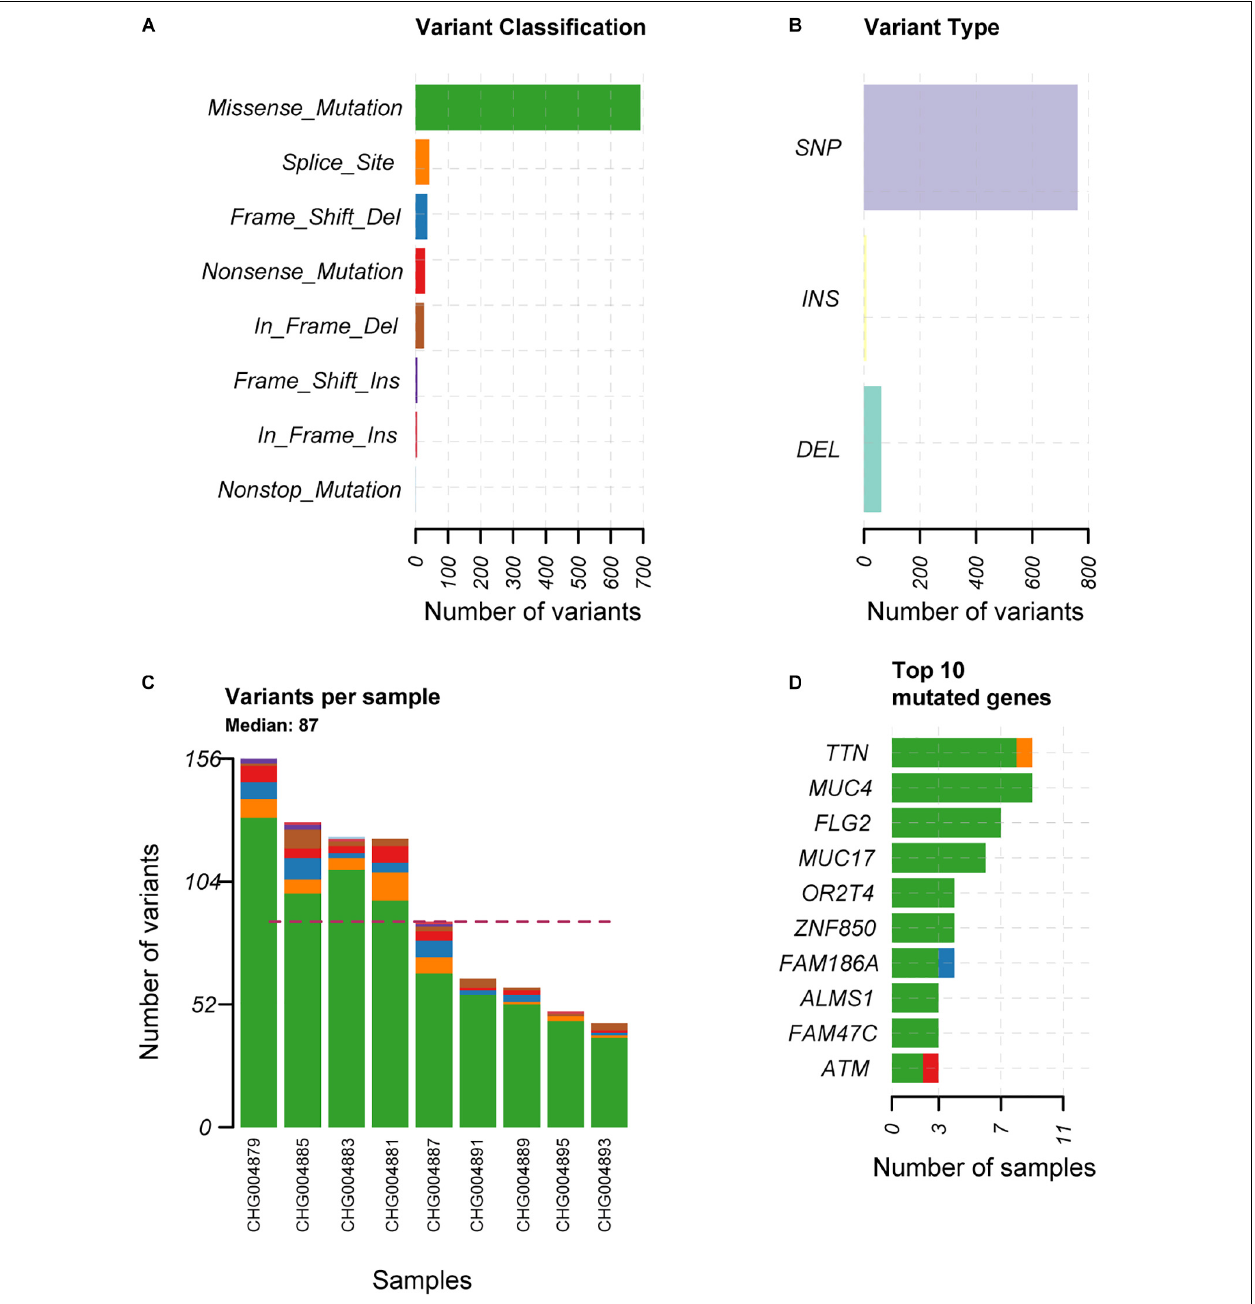
FIGURE 1 | The overview of the somatic mutations in spinal schwannoma. The variant classification, variant type, the number of variants per sample, and the top-ten mutated genes in the nine spinal schwannomas are displayed in (A–D) , respectively. The x -axis in (A,B,D) represent the number of mutations or samples. The x -axis in (C) represents the nine